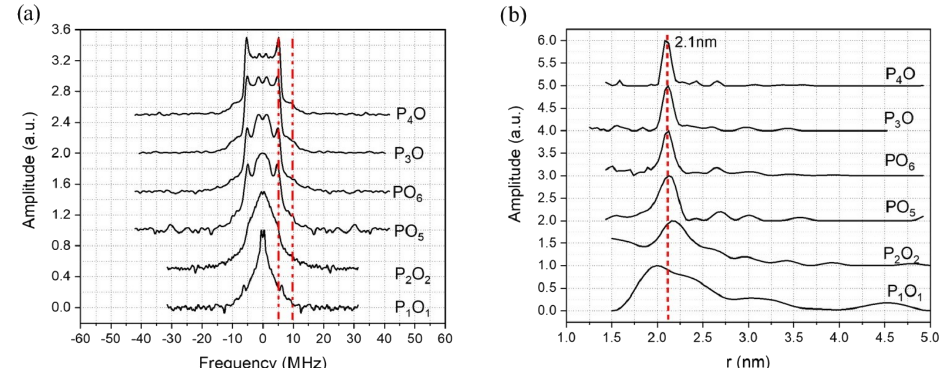
Figure 6. (a) Pake pattern spectra obtained from the fitting of the DEER data of the Gd-ruler (2.1nm) sample measured with different offsets between pump and observer pulses and (b) associated distance distributions derived from the DEER data. The corresponding frequency offsets are P 1 O 1 = 120MHz, P 2 O 2 = 420MHz, PO 5 = 840MHz, PO 6 = 900MHz, P 3 O = 800MHz and P 4 O = 900MHz. The red vertical dashed lines show in (a) the positions of the parallel and perpendicular singularities of the Pake pattern and in (b) the expected